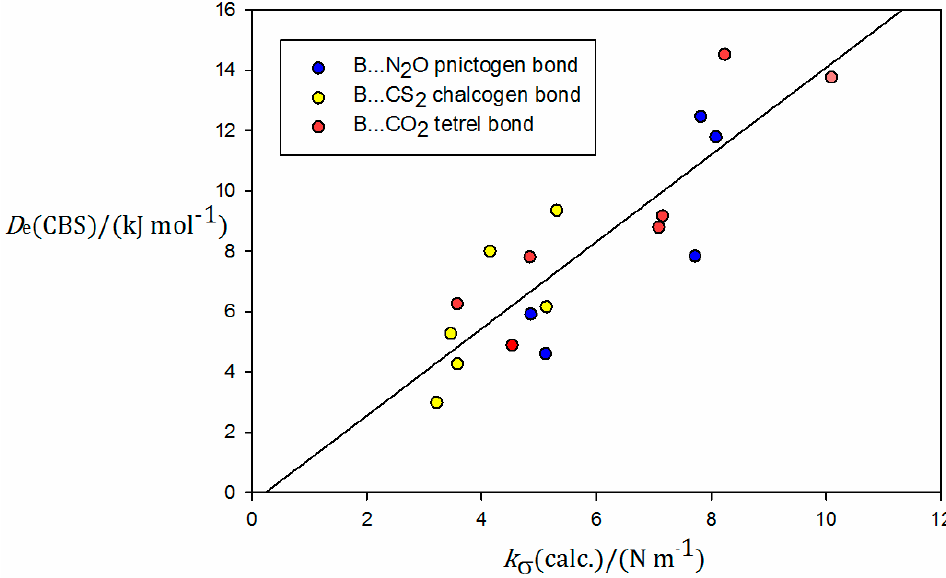
Figure 7. Plot of D e calculated at the CCSD(T)/CBS level of theory (CBS indicates a complete basis-set extrapolation using the aug-cc-pV n Z ( n = T and Q) basis sets) versus k σ calculated at the CCSD(T)/aug-